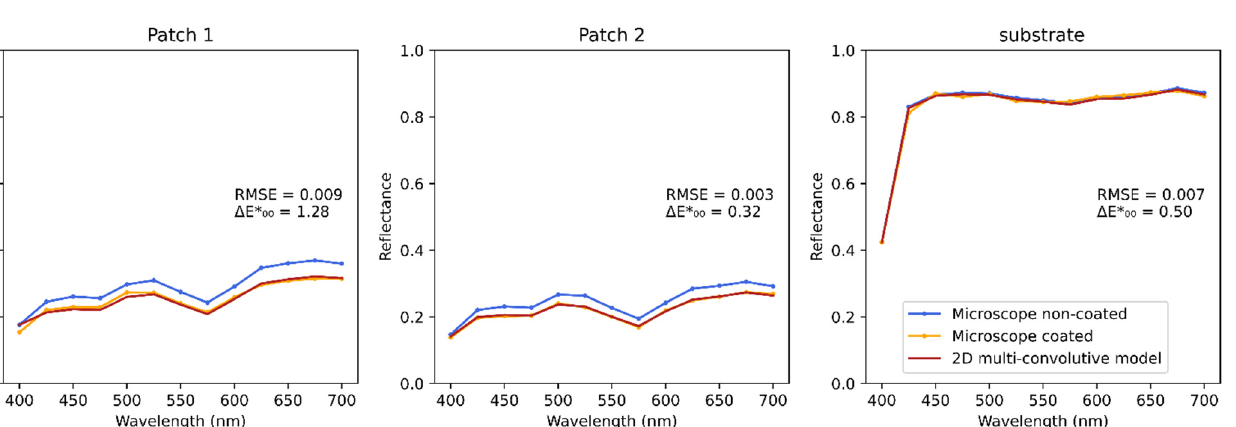
. Figure 12. sRGB pictures of the multi-ink dot halftones: non coated on the left, predicted in the middle, and coated on the right. The performances of the microscope measurement system and of the model are sum- marized in Table 1. The performances of the model are also displayed when the parameter γ is not fitted, i.e., equal to 1. The results are further discussed in Section 4. Table 1. Performances of the measurement system and of the optical model.